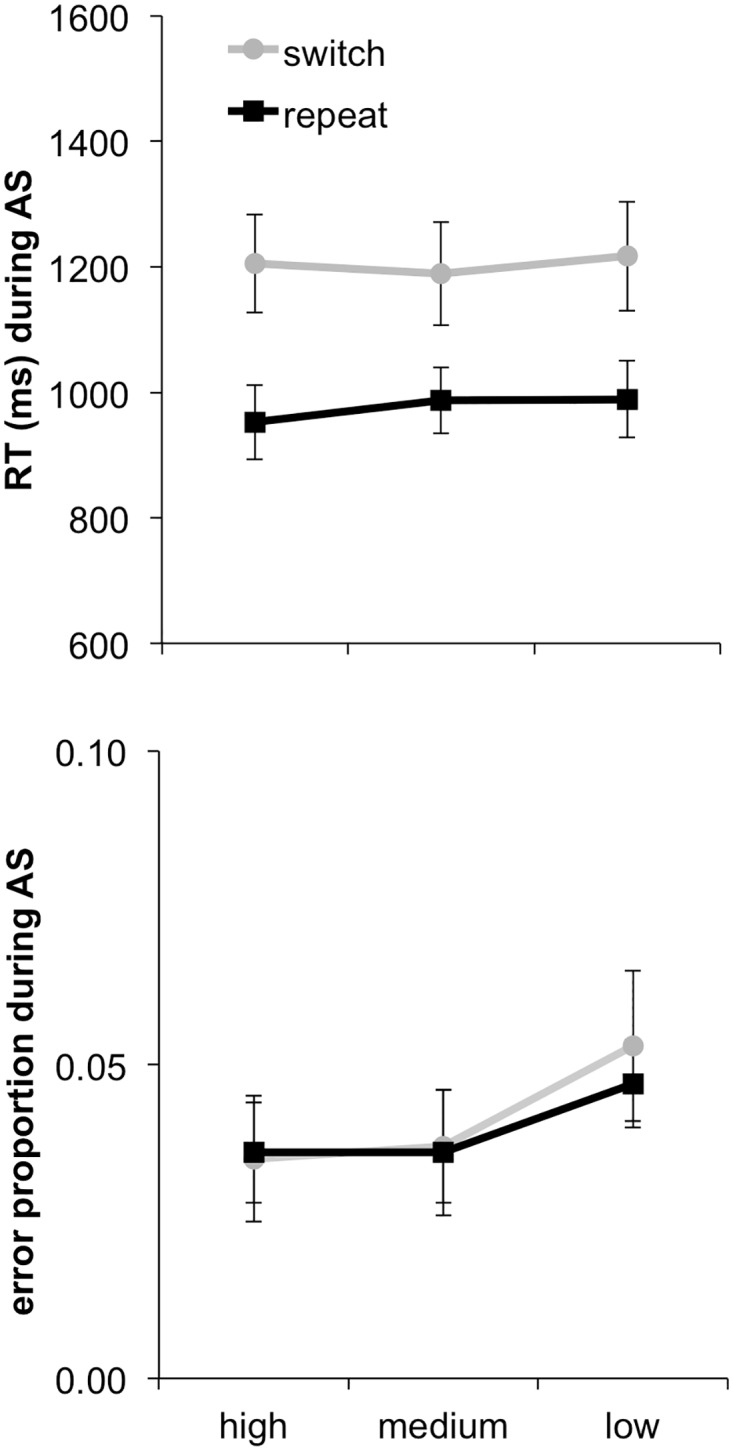
RTs and error rates for high, medium (med), and low global memory trials separately for switch and repeat trials.AS = Attention switching. Error bars indicate standard errors of the mean.